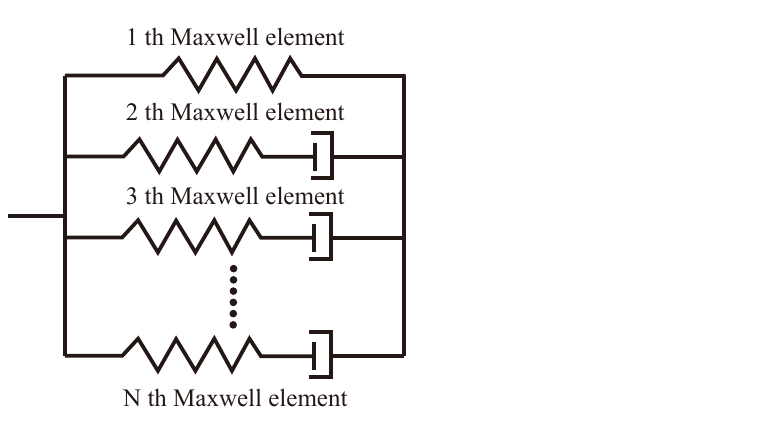
Figure 4. Illustration of the generalized Maxwell